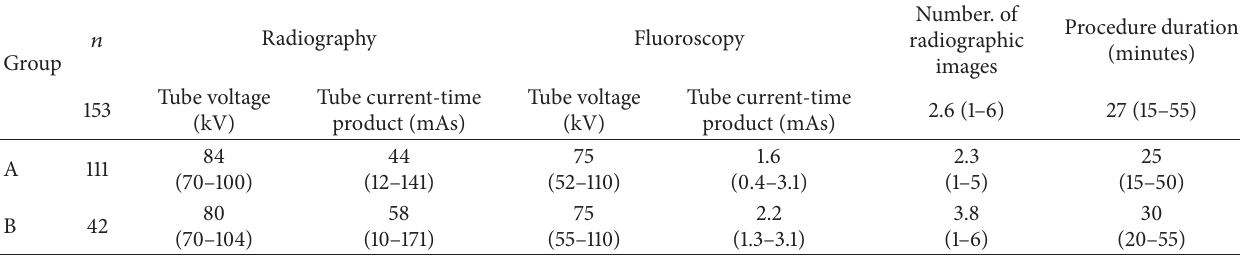
Table 2: The mean and range of the exposure parameters for radiography and fluoroscopy for both patients groups.